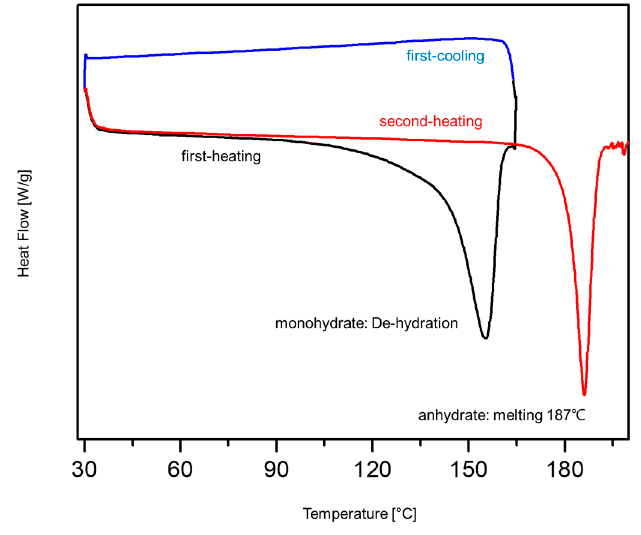
Figure 7. DSC heating-cooling-heating scanning (10 °C/min) curve of DBE monohydrate crystal: first-heating (black, temperature range: 30 °C–160 °C), first-cooling (blue, temper- ature range: 160 °C–30 °C), second-heating (red, temperature range: 30 °C–190 °C).